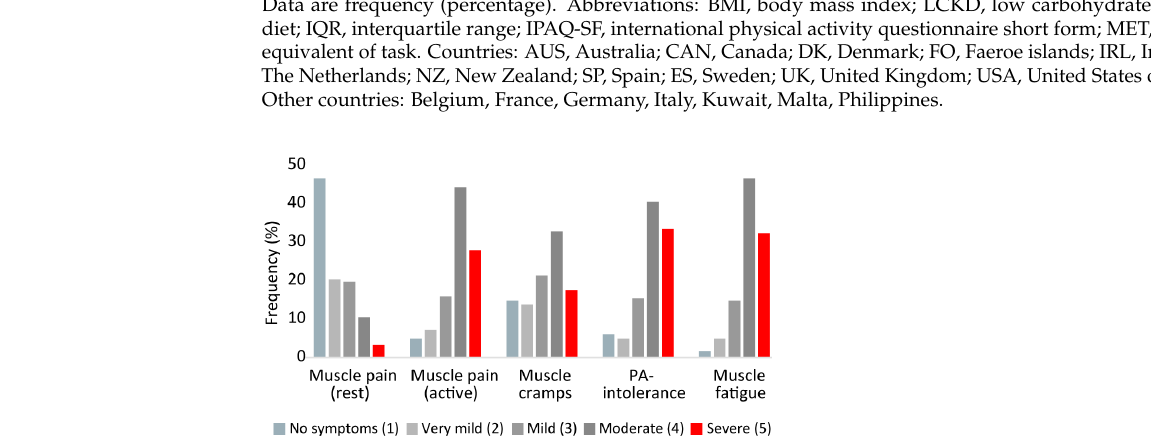
Figure 1. Distribution of McArdle disease-related symptoms. PA: physical activity. Based on n = 183 responses.